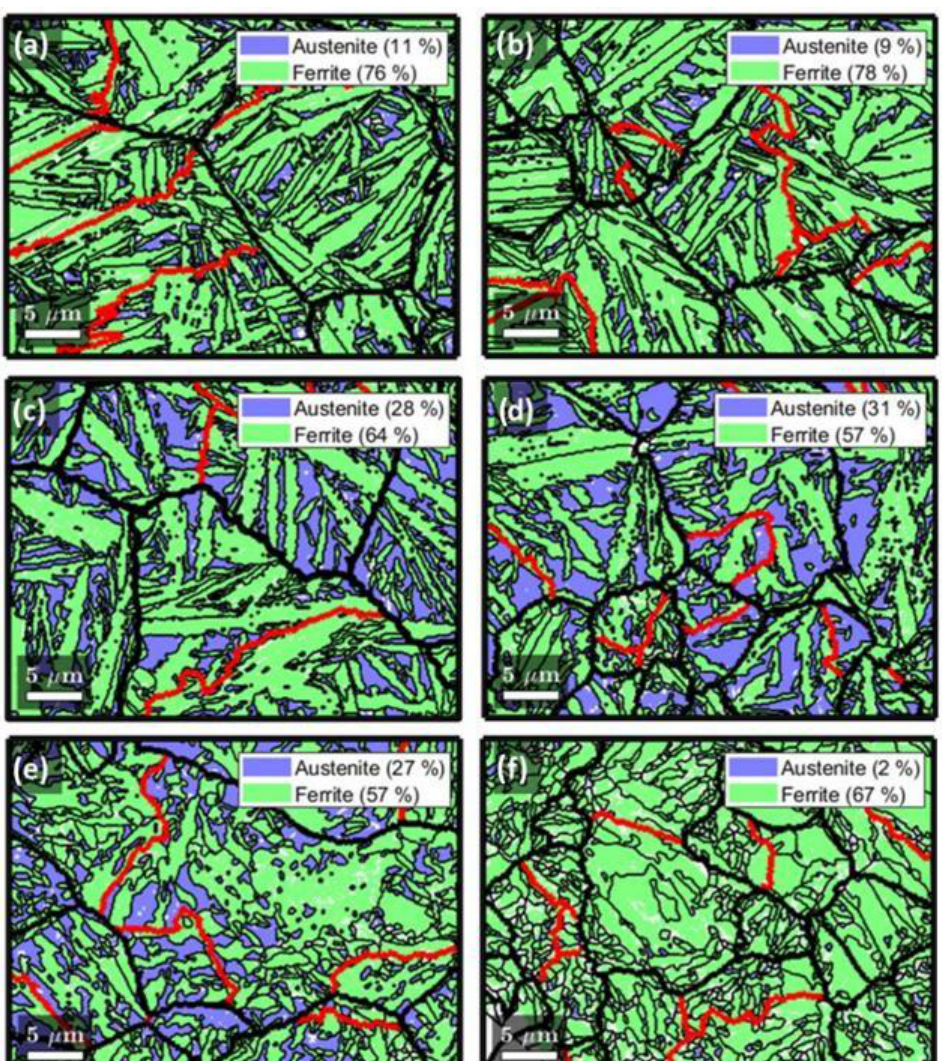
Figure 13. Clean phase maps, where the area percentage of austenite and ferrite are indicated in the legends. The maps correspond to the microstructures ( a ) 280—Dendritic; ( b ) 280—Interdendritic; ( c ) 330—Dendritic; ( d ) 330—Interdendritic; ( e ) 380—Dendritic; ( f ) 380—Interdendritic. The ferrite grain boundaries are depicted by black thin solid lines, the prior austenite grain (PAG) boundaries are represented by black thick solid lines, and the twin boundaries are represented by red thick solid lines.